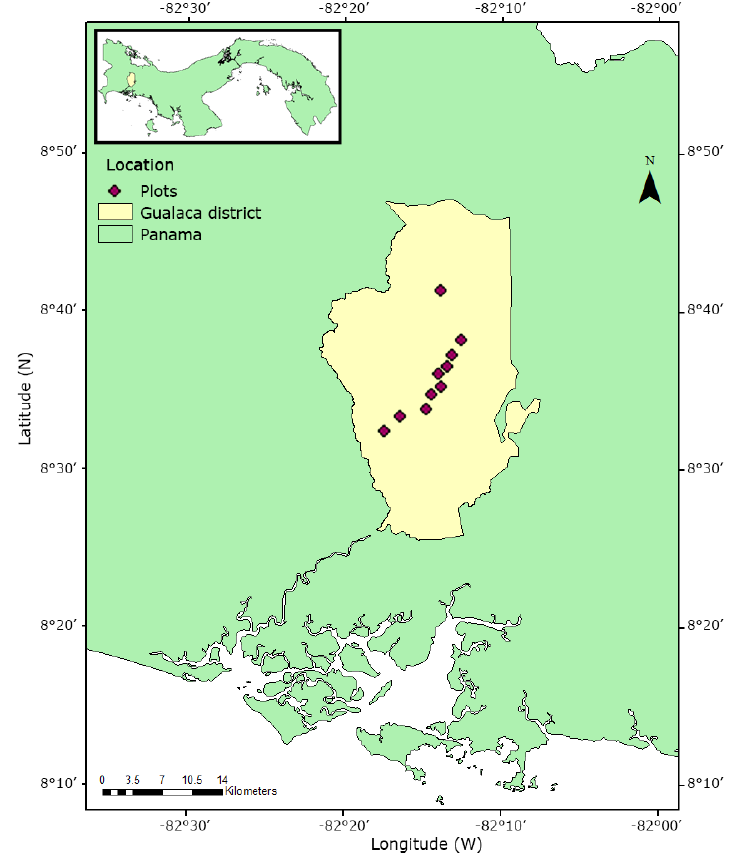
Figure 1. Study area in Gualaca district in southwest Panama. Ten plots were established along the elevational gradient from 100 to 1240 m a.sl. In each plot, ten trees were selected, and their epiphyte assemblages were studied.